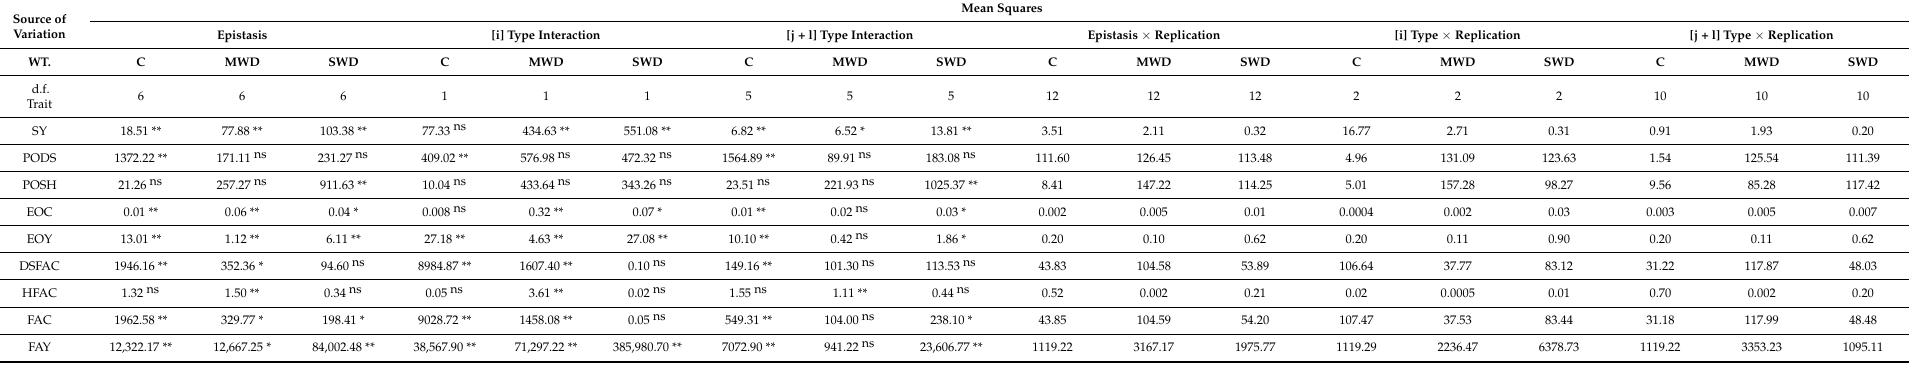
Table 2. Analysis of variance for the detection of epistasis for different traits in coriander under control (C), moderate water deficit (MWD), and severe water deficit (SWD) treatments. Sourceof